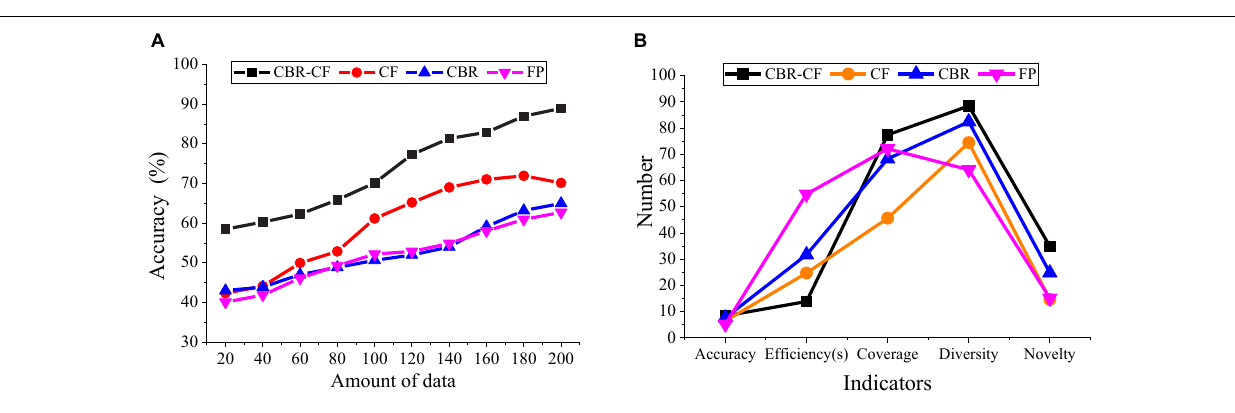
FIGURE 12 | Comparison and analysis of the performance of different recommendation systems. (A) Analysis chart of recommendation accuracy of different recommendation systems. (B) Comprehensive comparison and analysis chart of the performance of different recommendation